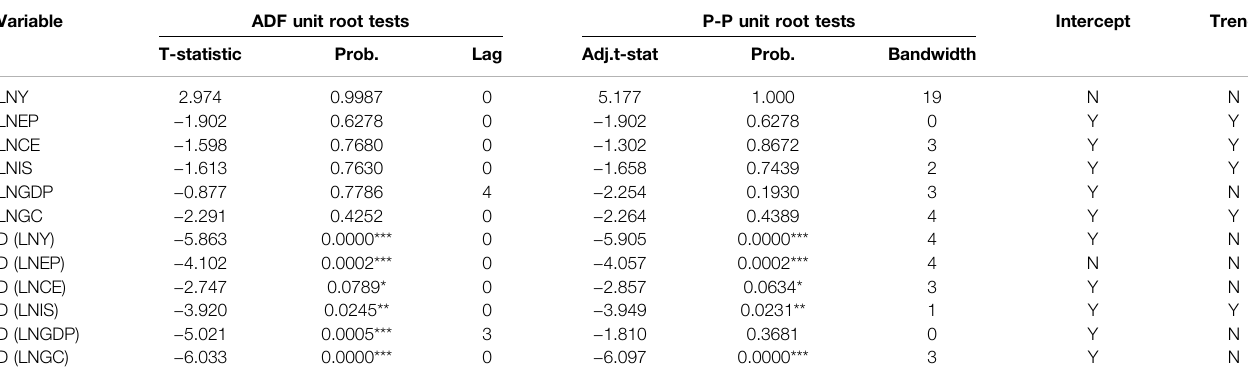
TABLE 2 | Conventional unit root tests. Variable